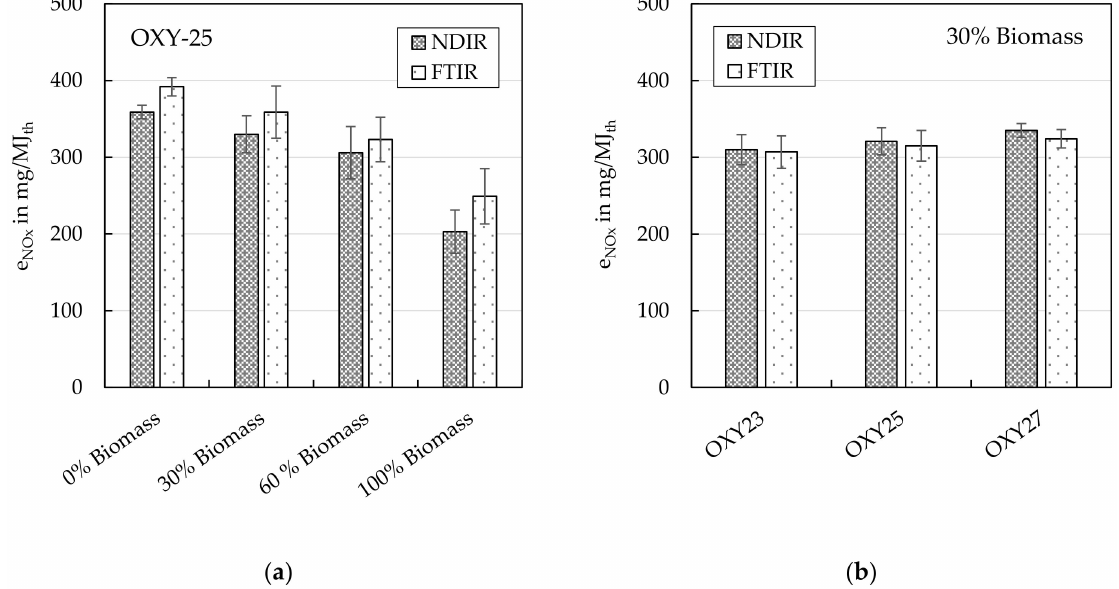
Figure 3. Specific NO x emissions ( e NO